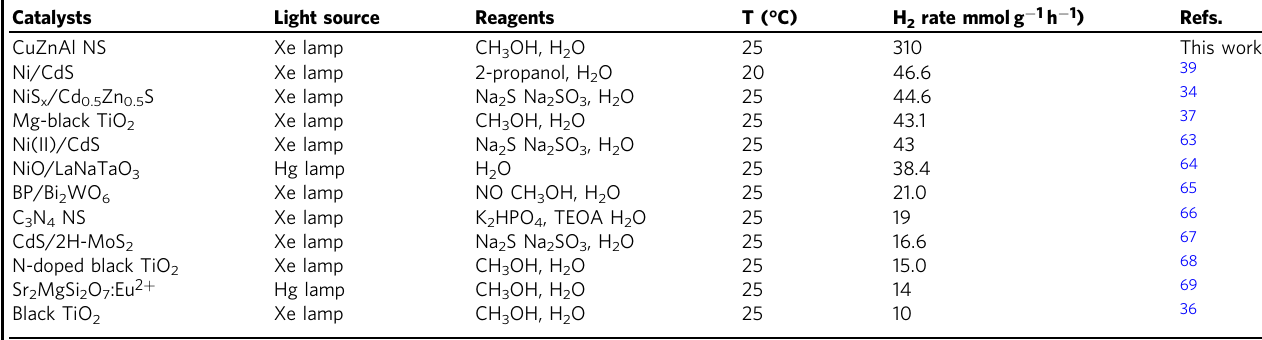
Fig. 5 Solar-heating MSR performance of CuZnAl NS with a Bi 2 Te 3 /Cu-based device. a Hydrogen production rates from the MSR of CuZnAl NS loaded in the Bi 2 Te 3 /Cu-based device and the device without CuZnAl NS under different sunlight irradiation. b Visual contrast diagram of the hydrogen production rates achieved under 1 sun illumination by the Bi 2 Te 3 /Cu-based device loaded with CuZnAl NS and those of other photocatalysts. c STH ef fi ciency of MSR achieved by the Bi 2 Te 3 /Cu-based device loaded with CuZnAl NS under different intensities of solar irradiation. d Optical image of the solar-heating system used for hydrogen production from MSR under ambient sunlight irradiation. e Solar fl ux on April 08, 2021, in Baoding City, China. f MSR hydrogen production rate as a function of time under ambient sunlight irradiation. CuZnAl NS is the abbreviation for CuZnAl nanosheets. Table 1 Sunlight-driven hydrogen generation from the MSR of CuZnAl NS loaded in a Bi 2 Te 3 /Cu-based device in comparison with the reported advanced sunlight-driven hydrogen generation